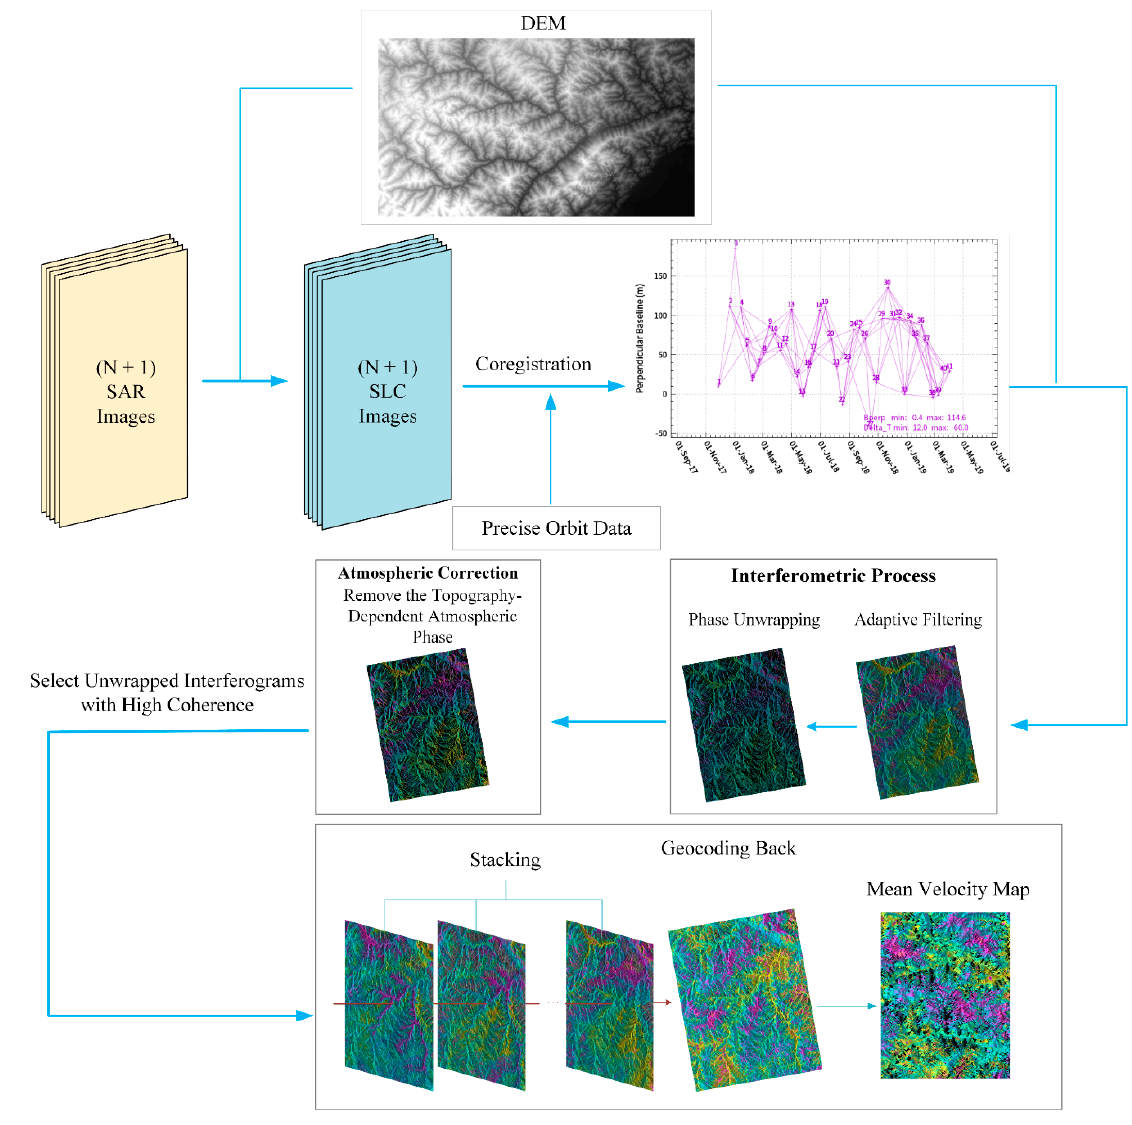
Figure 2. The flow chart of Stacking-InSAR method.